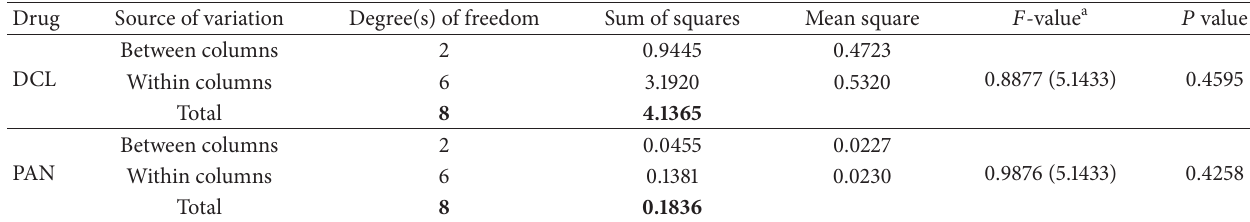
Table 5: Results of single factor ANOVA for comparison of proposed methods for the determination of diclofenac (DCL) and pantoprazole